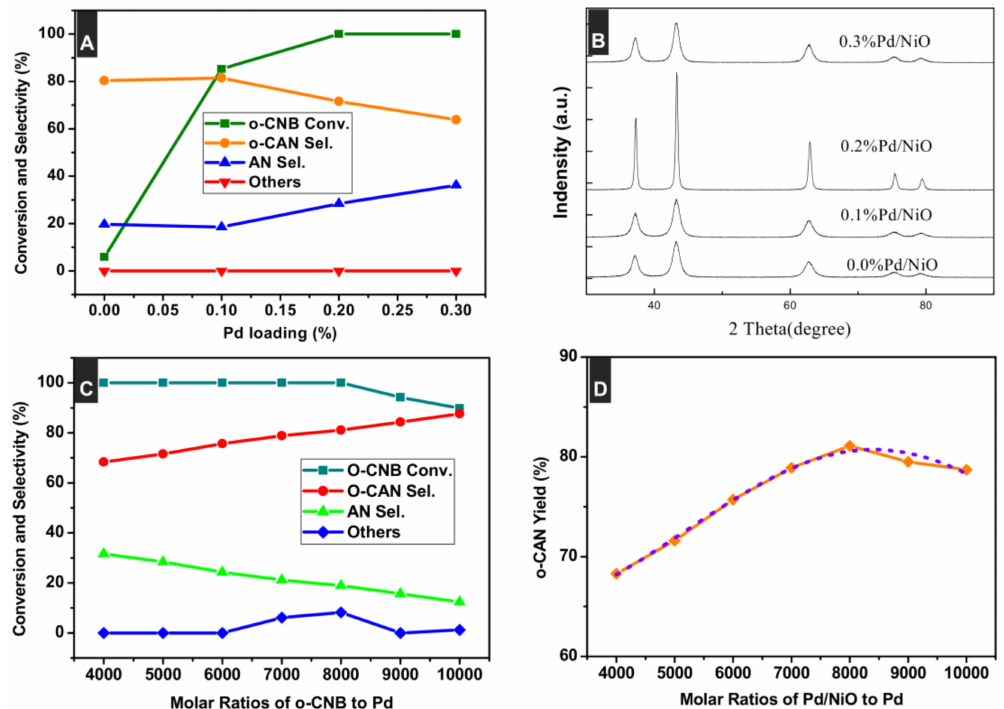
Figure 7. Effects of Pd content ( A ) and o -CNB /Pd molar ratios ( C , D ) upon the o -CNB hydrogenation. XRD patterns of NiO-loaded Pd catalysts with varied Pd content is shown in ( B ). In ( D ), orange solid line shows the actual trend of o -CAN yield meanwhile dash line is its Gaussian fitting curve. Conditions: ( A ): 60 ◦ C, 0.5 h, P (H 2 ) = 1 MPa, m cat. = 20 mg, n o -CNB /n Pd = 5000:1, V ethanol = 5 mL. ( C , D ): 60 ◦ C, 0.5 h, P (H 2 ) = 1 MPa, V ethanol = 5